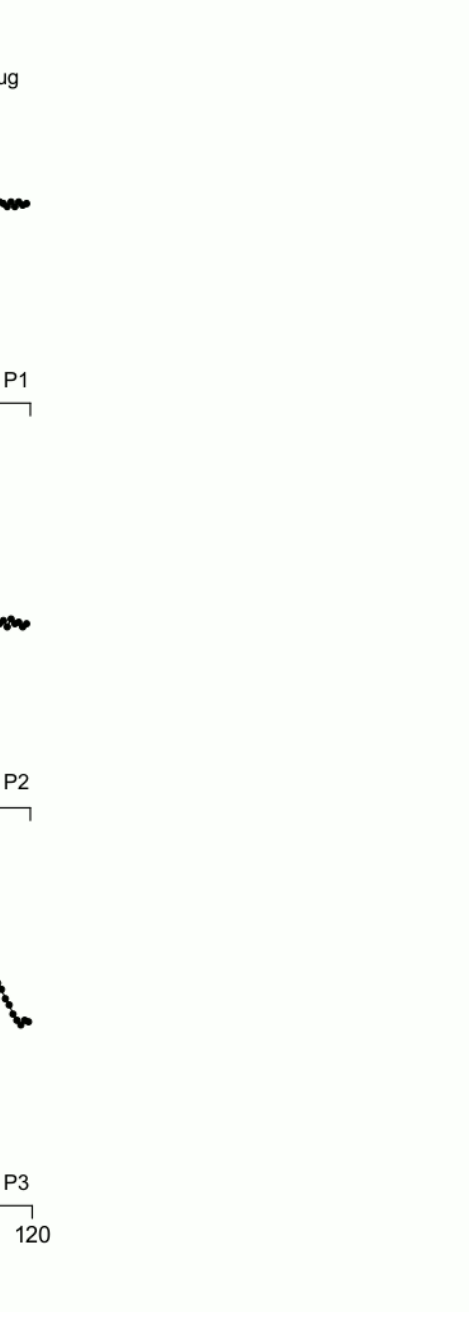
Figure 4. Example of a combined reversal and multiple baseline to determine the best drug to lower blood pressure. BL = Baseline. Drug X and Drug Y represent hypothetical drugs to lower blood pressure, and Best Drug represents a reversal to the most effective drug as identified for each hypothetical participant, labeled